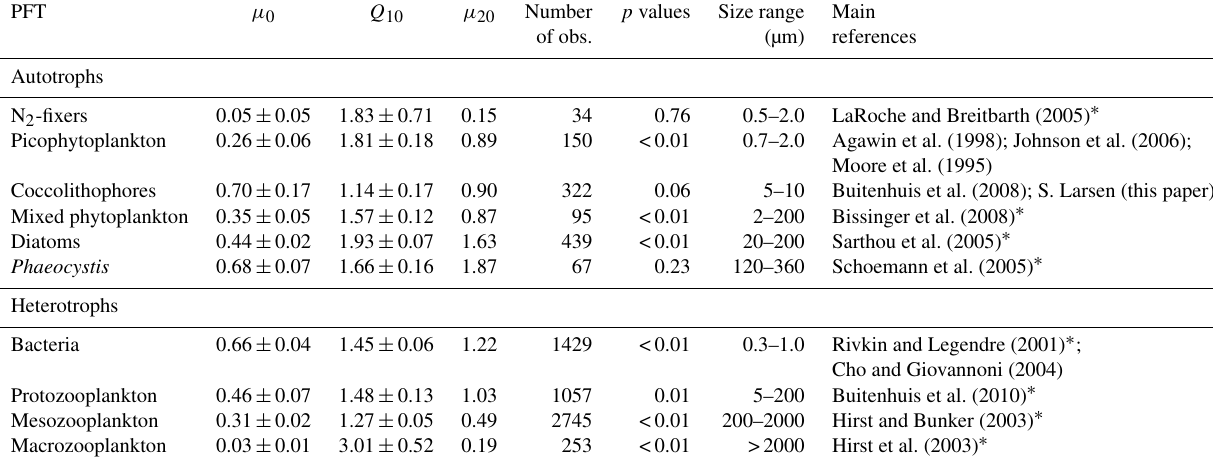
Table 1. Growth rates of PFTs at 0 and 20 ◦ C ( µ 0 and µ 20 ) and rate increase for a 10 ◦ C increase in temperature ( Q 10 ) . The uncertainty in µ 0 and Q 10 represents ± 1 standard deviation from an optimal parameter value in the parameter space. Full references for the phytoplankton growth rate data are provided in the Supplement. The zooplankton growth rate data are from the published data synthesis cited here. PFT µ 0 Q 10 µ 20 Number p values Size